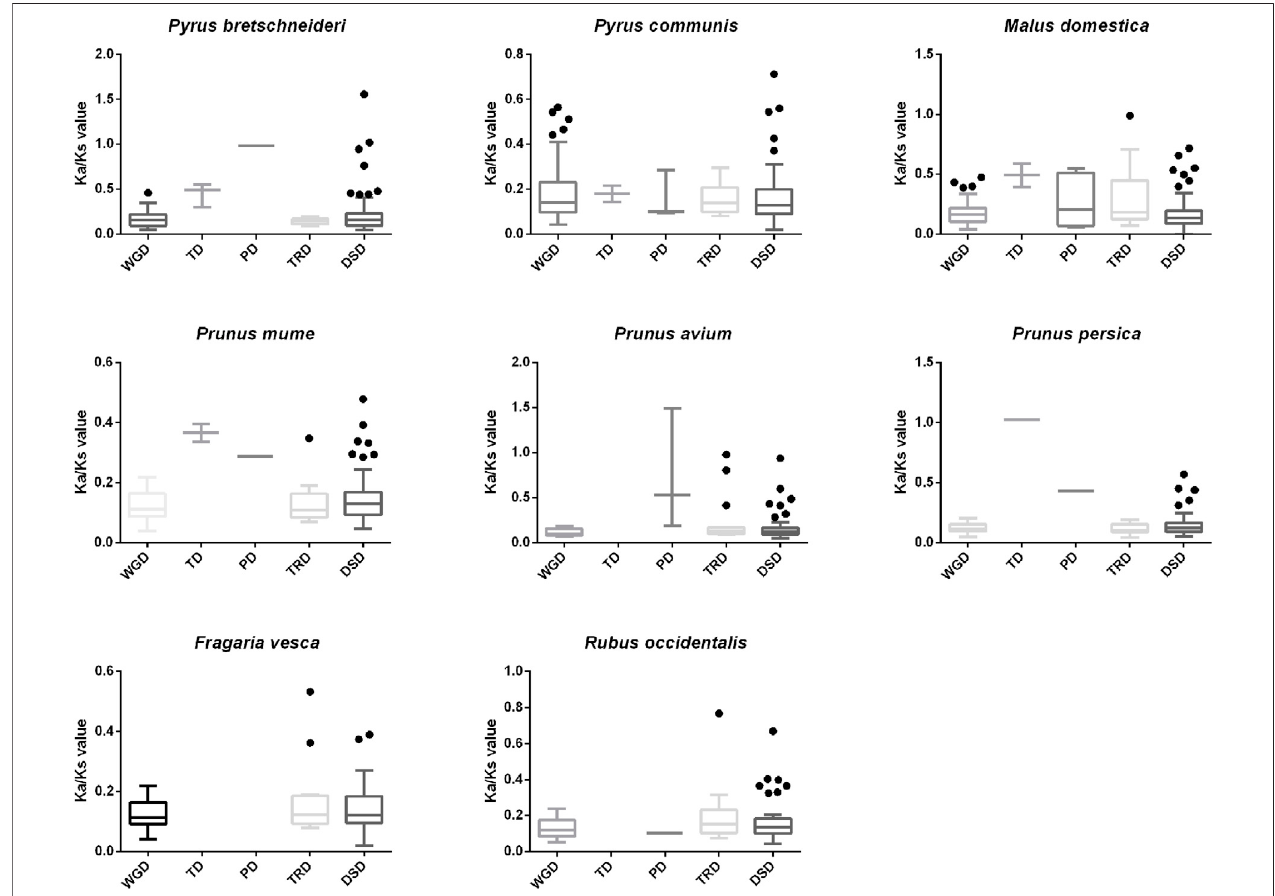
FIGURE 4 | Ka/Ks distribution of eight Rosaceae species. Ka/Ks values were analyzed using coding sequences. X -axis represents fi ve different duplication categories. Y -axis indicates the Ka/Ks ratio. T-boxplot was also constructed using prism 6.0.